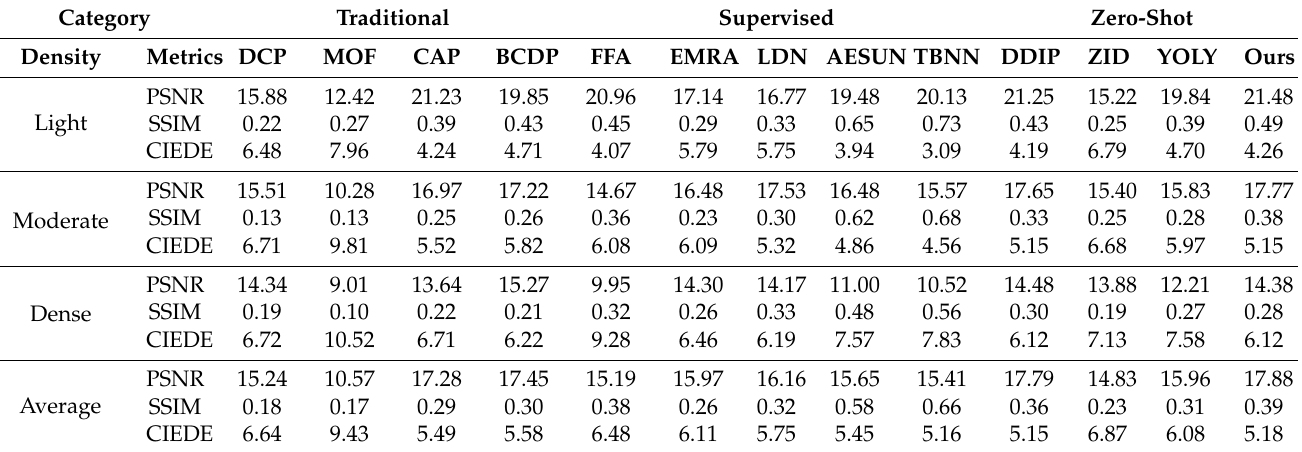
Table 4. Quantitative evaluation results on the RS non-uniform hazy dataset (RS-Haze). The best value of the specific metric for each category is in